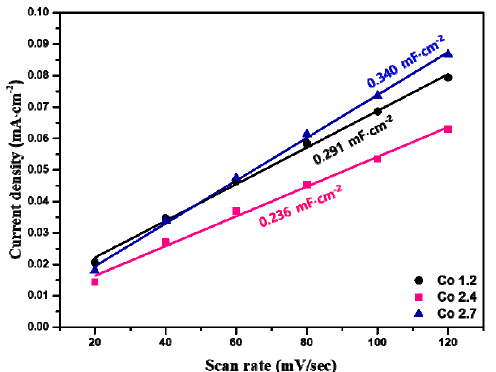
Figure 10. The current difference between anodic and cathodic sweeps as a function of scan rate for Co- and Mn-based the mixed phase materials (Co = 1.2, 2.4, and 2.7).